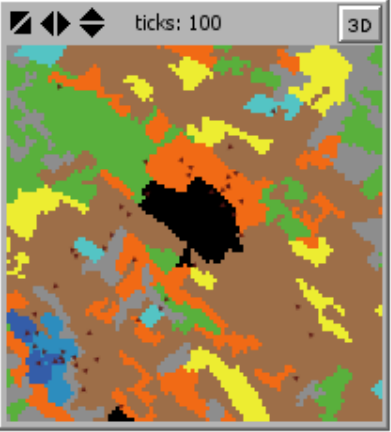
Figure 9. Shows 50 scouts after 100 ticks of simulation on the sample world The running time of the algorithms with 100 agents for 50 ticks or 50 agents for 100 ticks are roughly identical. After